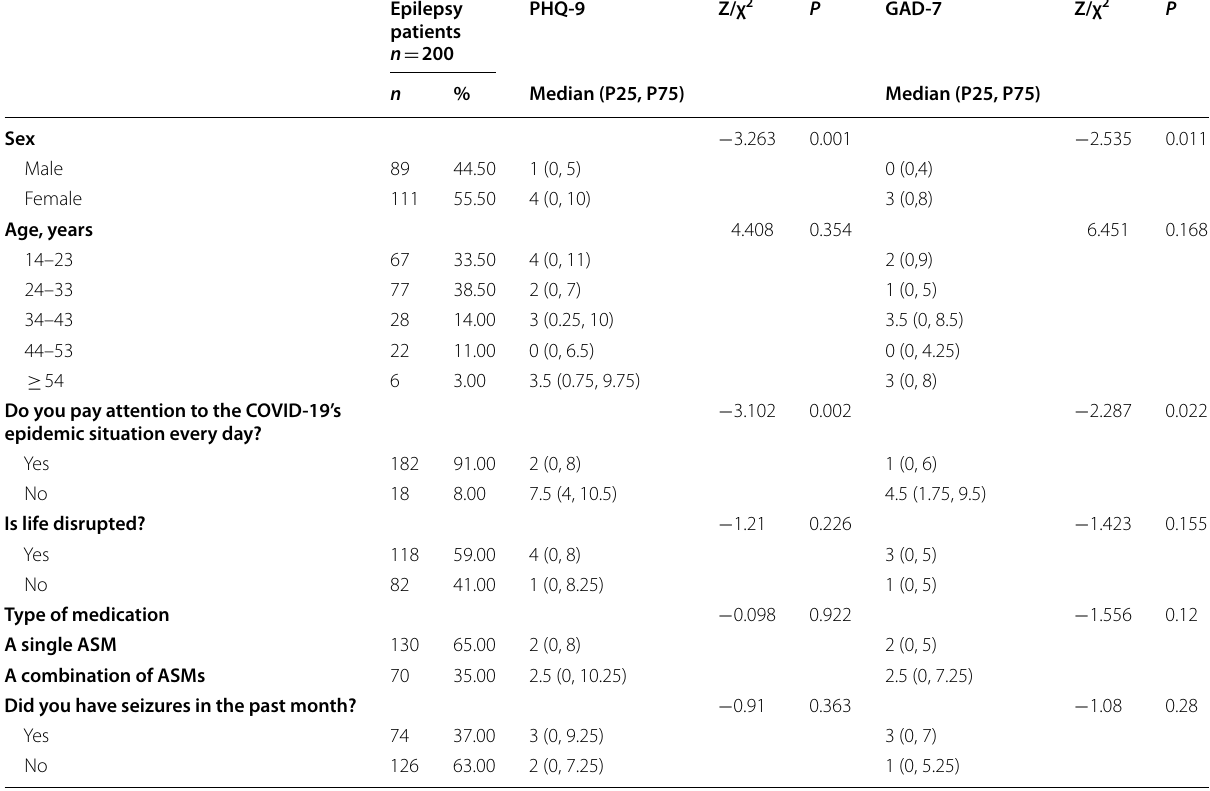
Table 4 Comparison of PHQ-9 and GAD-7 scores within the epilepsy